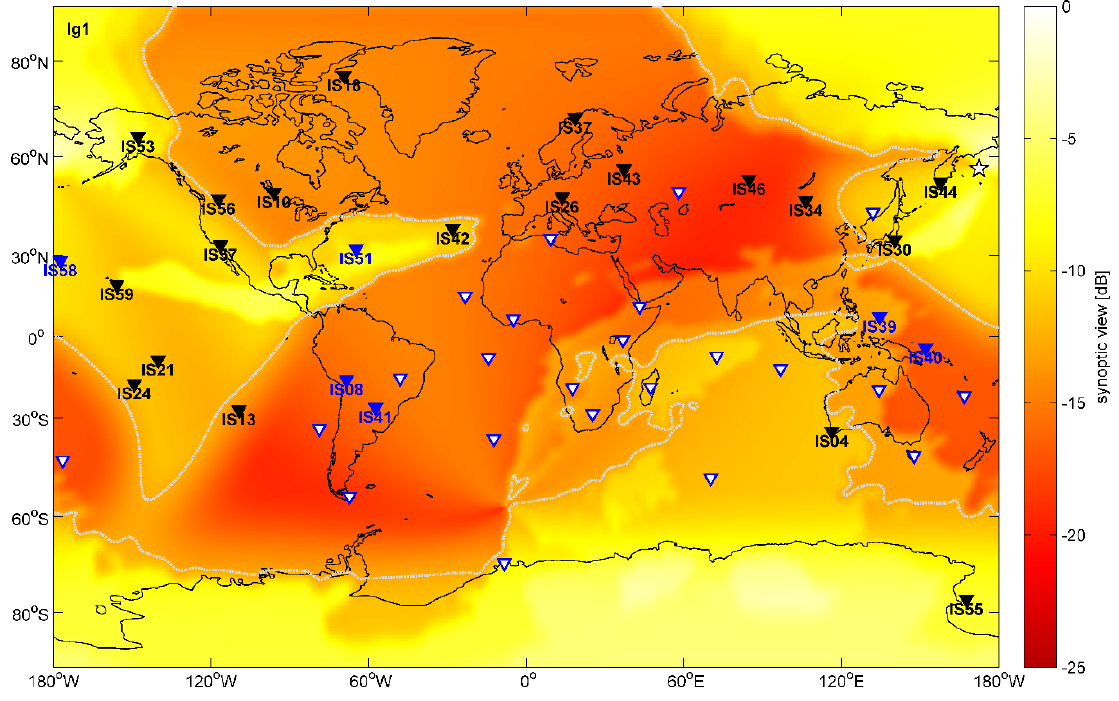
Figure 6. Synoptic view of the detection capability (including ducting, daytime, and directivity influences) for the Bering Sea fireball (white star) at all global stations up to 20,000 km distance (along short orthodrome Ig1). Color values are provided in dB (intensity reduction), respective to 0 dB for nighttime noise levels, perpendicular directions, and stratospheric ducting with high effective sound speed ratio. A contour line shows the mean value at −12.7 dB, distinguishing regions above and below this average. Higher (brighter) values indicate increased detection probabilities for these conditions compared to lower (darker) values otherwise. Stations that performed detections are shown with black or blue triangles and labels (when also identified in the REB or not, respectively), while stations performing no detections are indicated by white triangles.